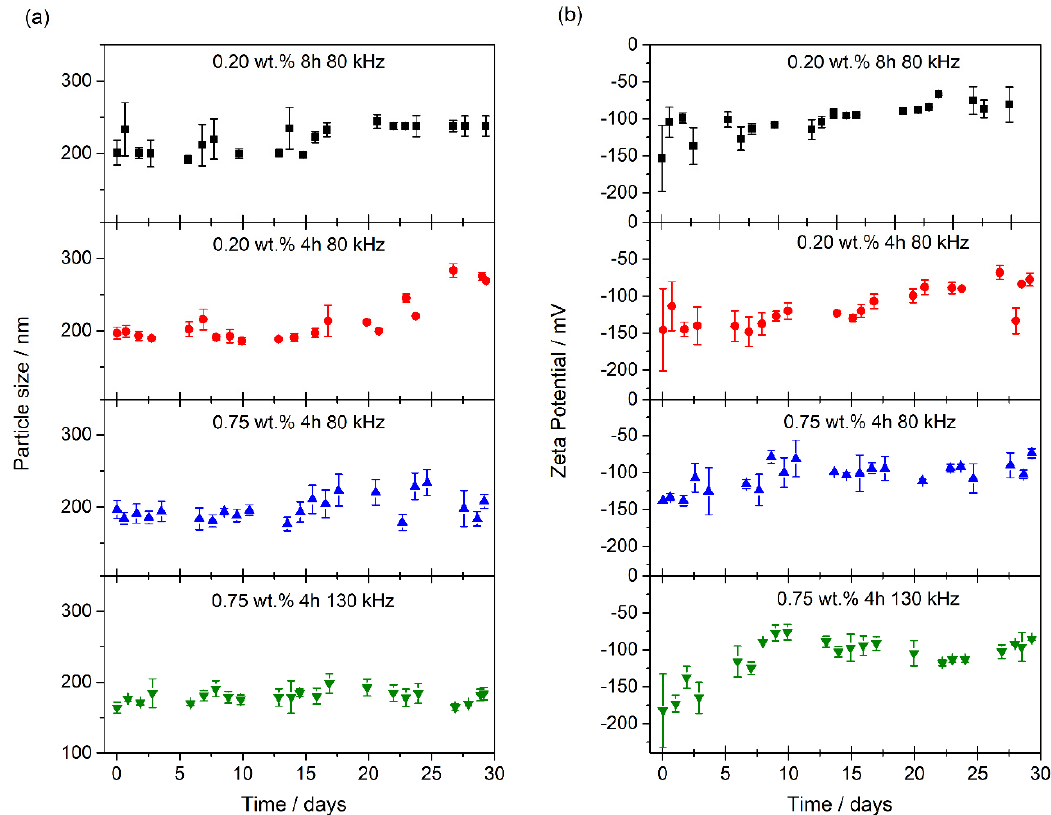
Figure 5. Evolution with time of particle size ( a ) and ζ potential ( b ) for the nanofluids prepared. Table 3. Density, volume fraction and viscosity values of heat transfer fluid (HTF) and 2D-WS 2 -based nanofluids at 25 ◦